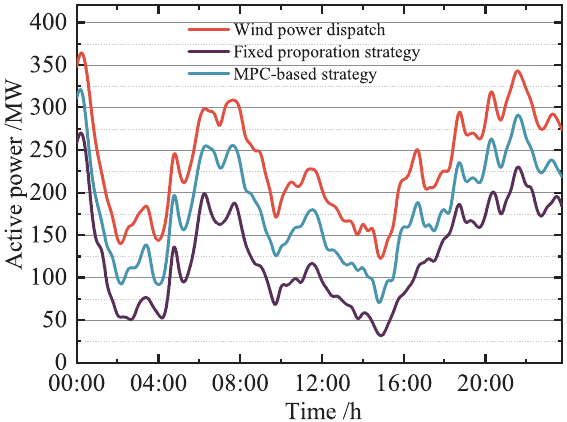
Figure 10. Wind power cluster curve of